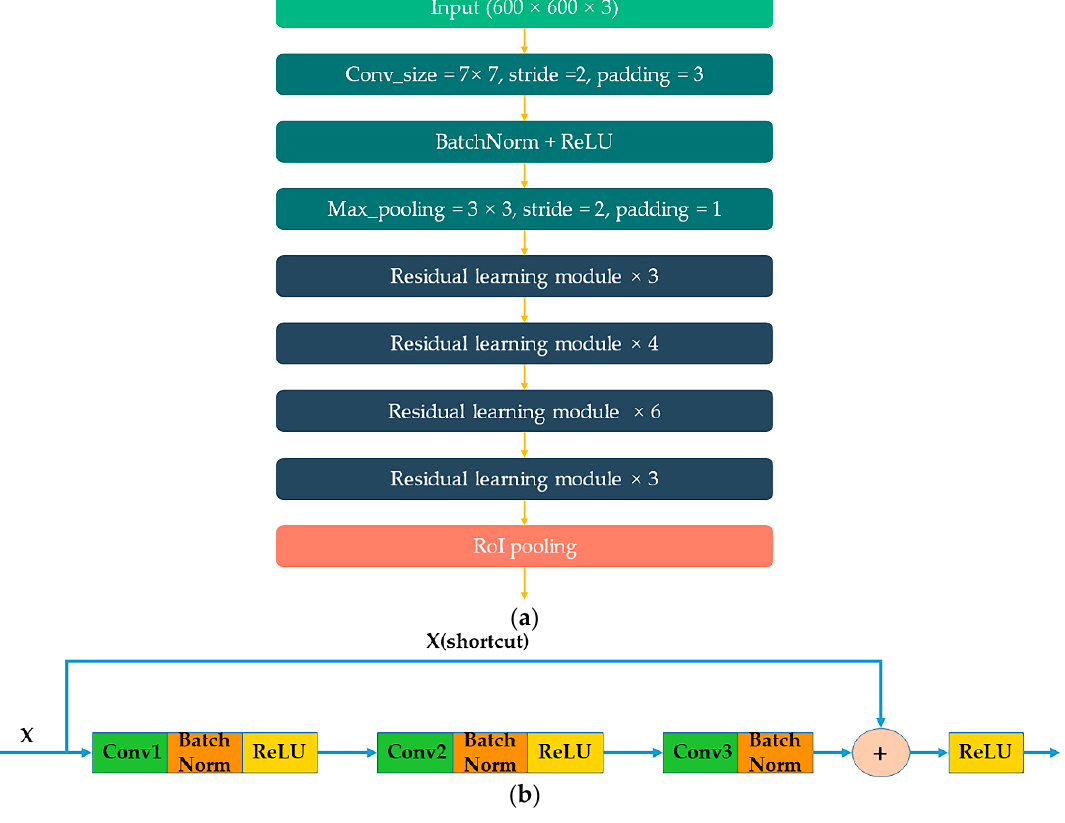
Figure 6. ( a ) The structure of residual neural network 50 (ResNet50) and ( b ) the core structure of the residual learning module in ResNet50. Conv represents convolution neural network, Conv1 and Conv3 kernel size is 3 × 3, Conv2 kernel size is 1 × 1, padding is 1, stride is 1 and activation function is ReLU.